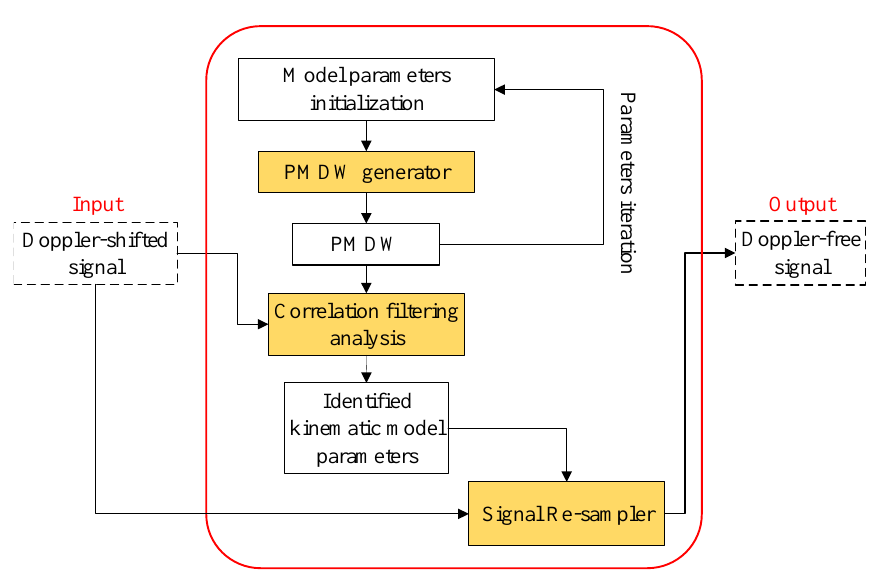
Figure 3. Flowchart of the Doppler effect